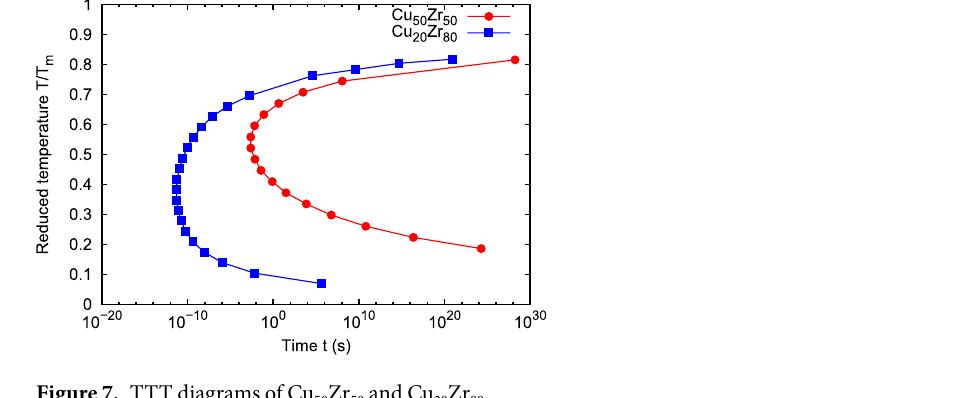
Figure 7. TTT diagrams of Cu 50 Zr 50 and Cu 20 Zr 80 .